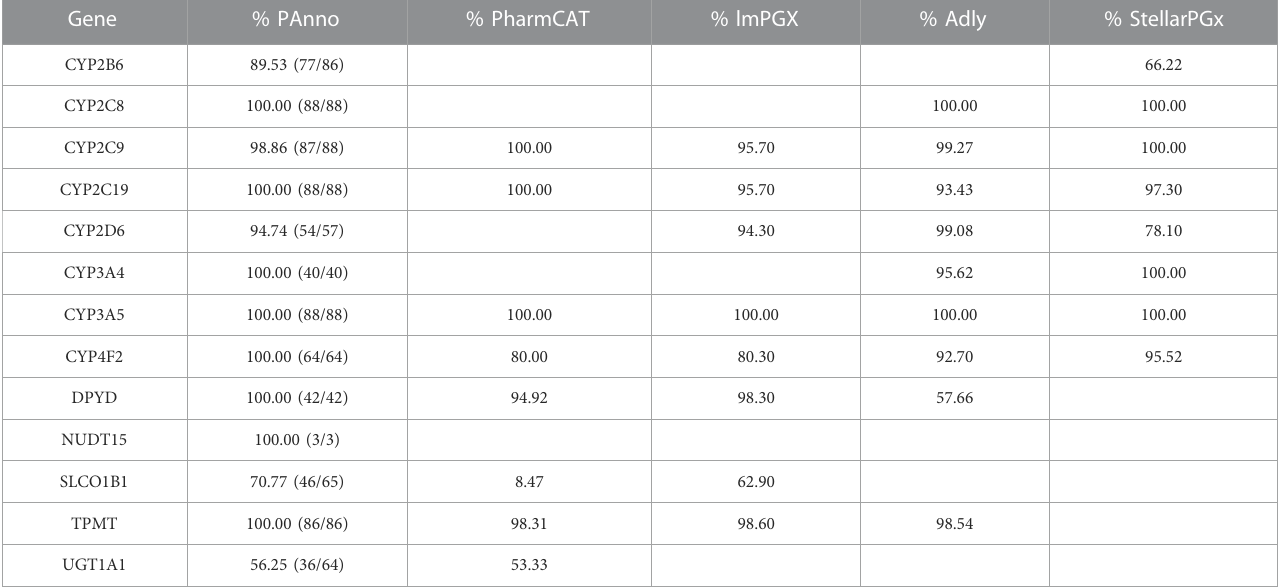
TABLE 2 Performance of PAnno and similar tools in diplotype inference.